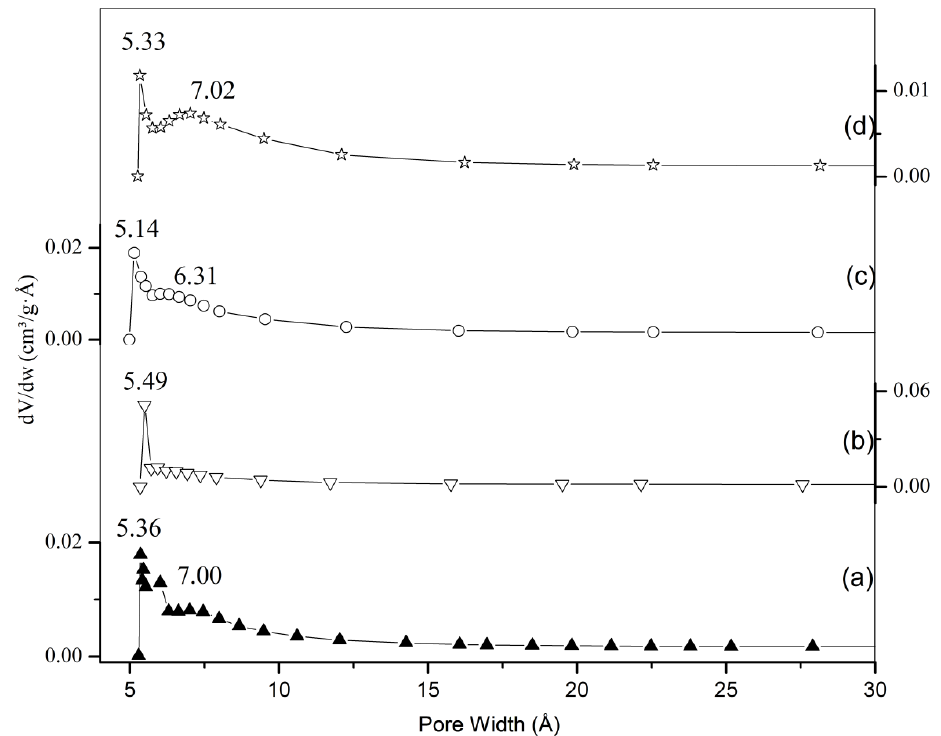
Figure 7. Micropore size distribution (obtained by HK method): ( a ) γ -Al ( c ) MnAlT400W and ( d )